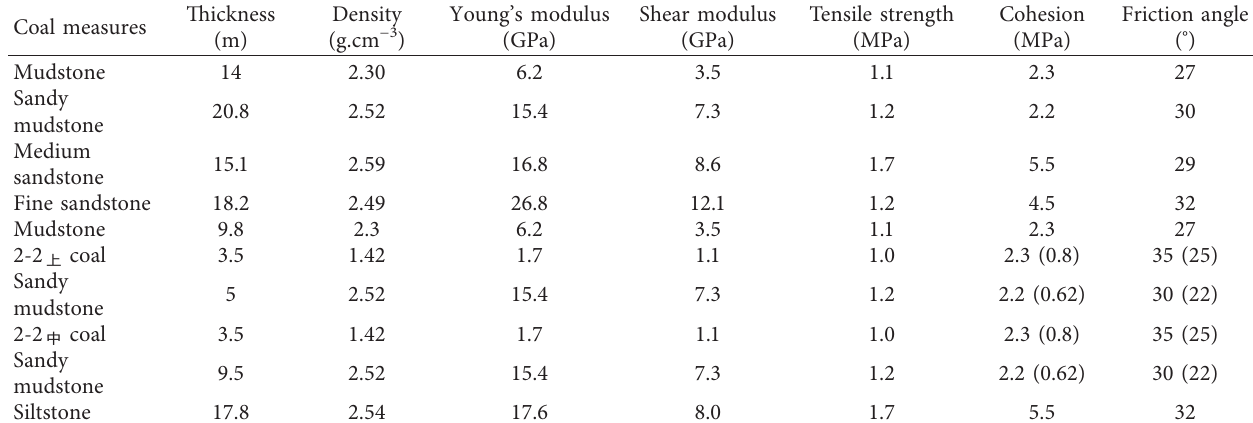
Table 2: Mechanical properties of the coal measures that are used in the model.